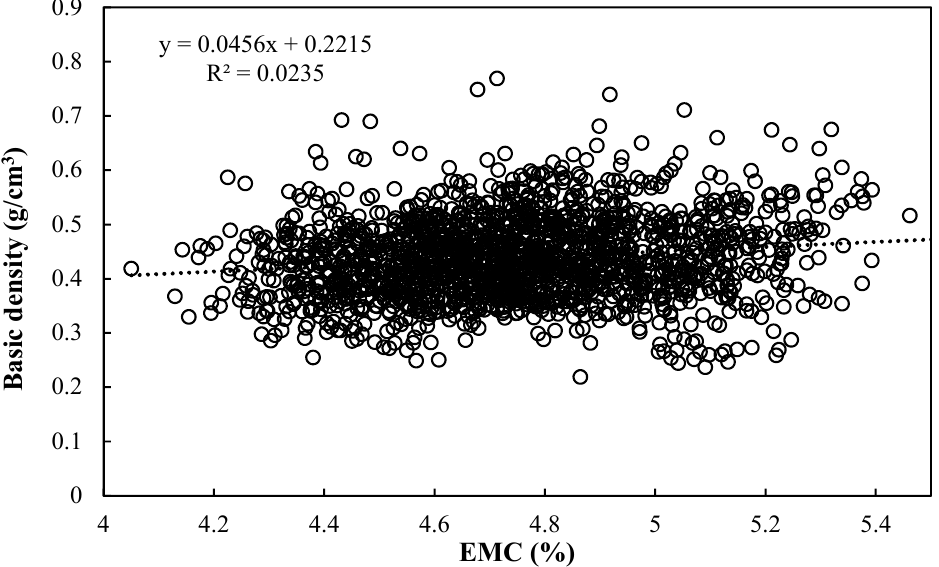
Data are show as mean with di ff erent group in letters; values in parentheses represent for standard deviation. MC, moisture content; BD, basic density; MOR, module of rupture; MOE, module of elasticity; σ , ultimate stress in compression parallel to the grain; E, Young’s modulus in compression parallel to the grain. Figure 2. Variation of moisture content (%).